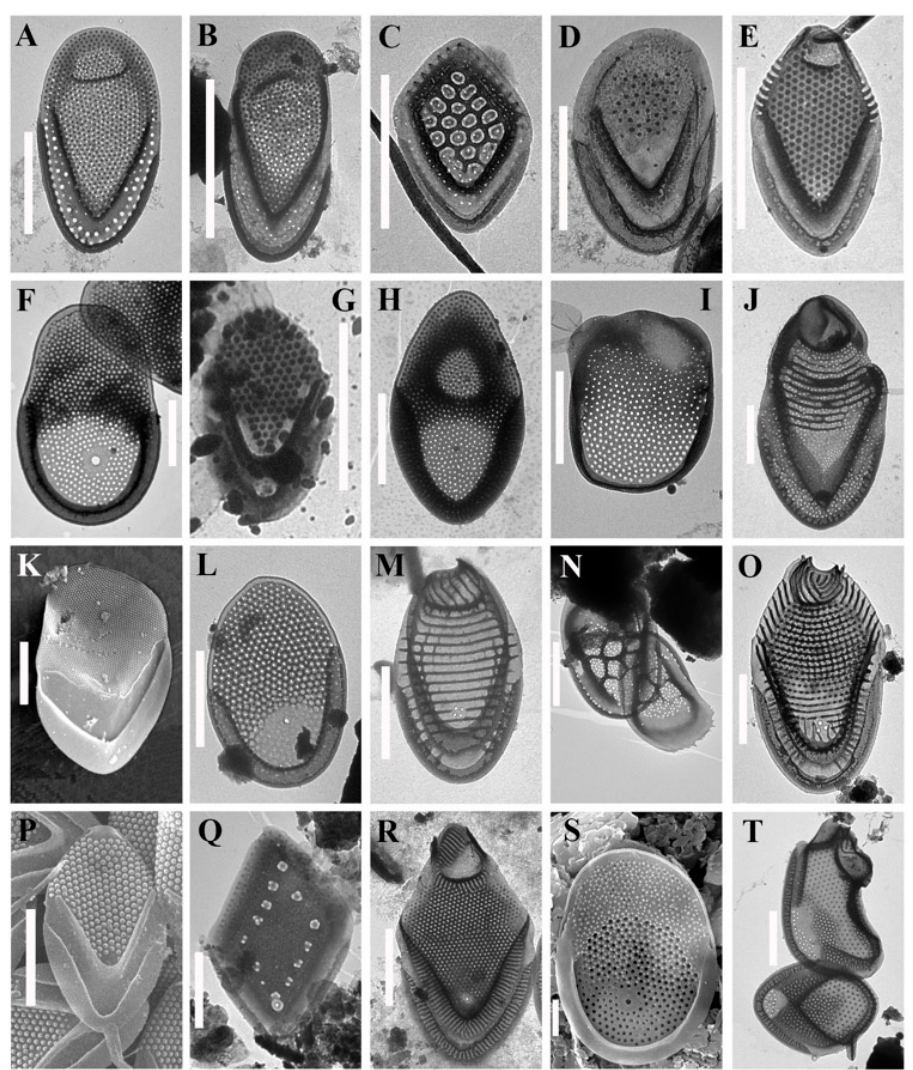
Figure 4. Scales of Mallomonas . ( A ) M. multisetigera . ( B ) M. neoampla . ( C ) M. ocellata . ( D ) M. cf. ouradion . ( E ) M. papillosa . ( F ) M. paragrandis . ( G ) M. parvula [43]. ( H ) M. peronoides . ( I ) M. plumosa . ( J ) M. portae-ferreae . ( K ) M. pseudobronchartiana . ( L ) M. pseudomatvienkoae . ( M ) M. pseudocratis . ( N ) M. punctifera . ( O ) M. punctostriata . ( P ) M. rasilis . ( Q ) M. siderea . ( R ) M. skvortsovii . ( S ) M. sorohexareticulata